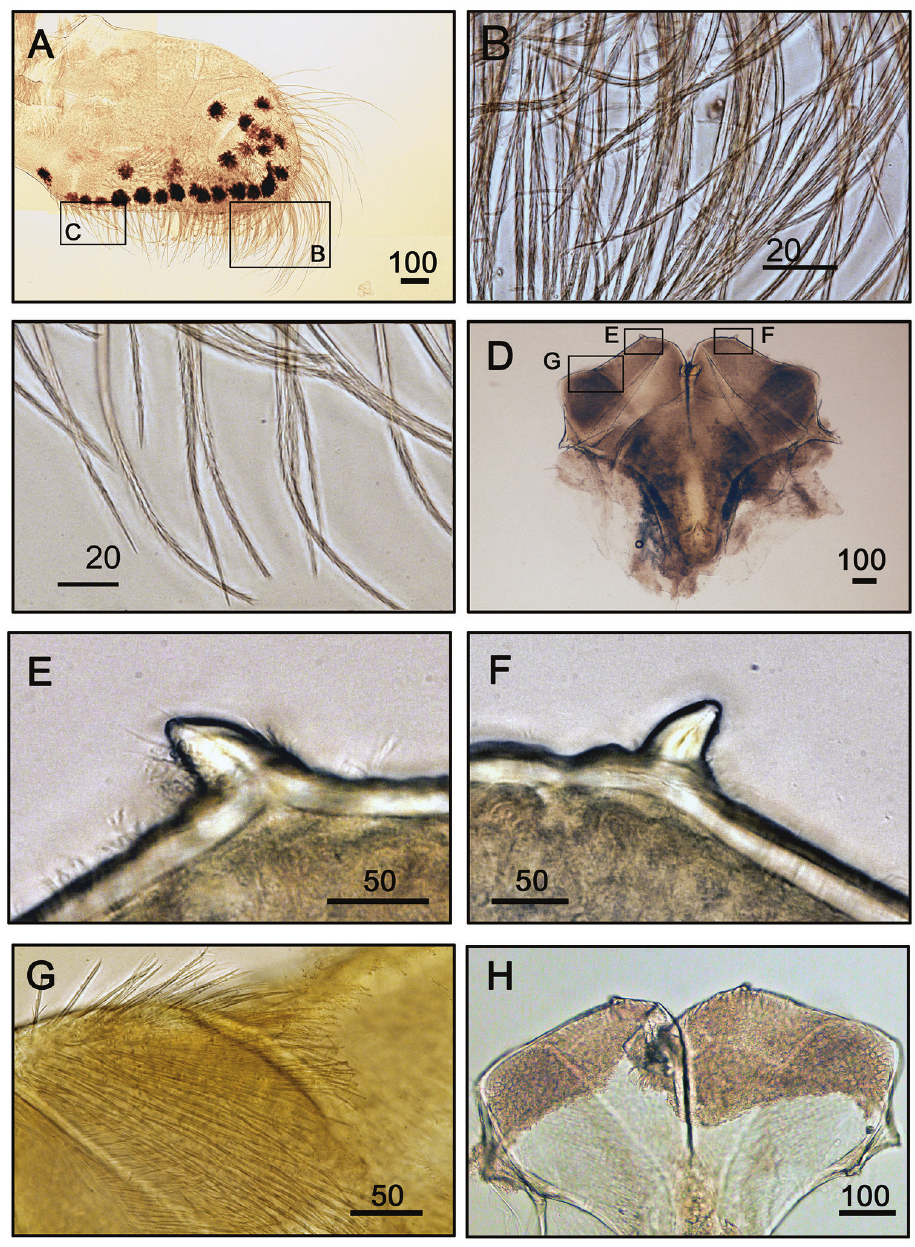
Figure 6. Mandibular palp and labrum of Galkinius maculosus sp. n. A Mandibular palp showing black spots (ASIZCR000343) B Serrulate setae distally C Serrulate setae on interior margin D Bilobed labrum with V-shaped notch between two lobes (ASIZCR000343) E Tooth on labrum F Tooth on labrum G Surface of labrum with simple setae H Bilobed labrum (CEL-DSA-012-6). Scale bars in